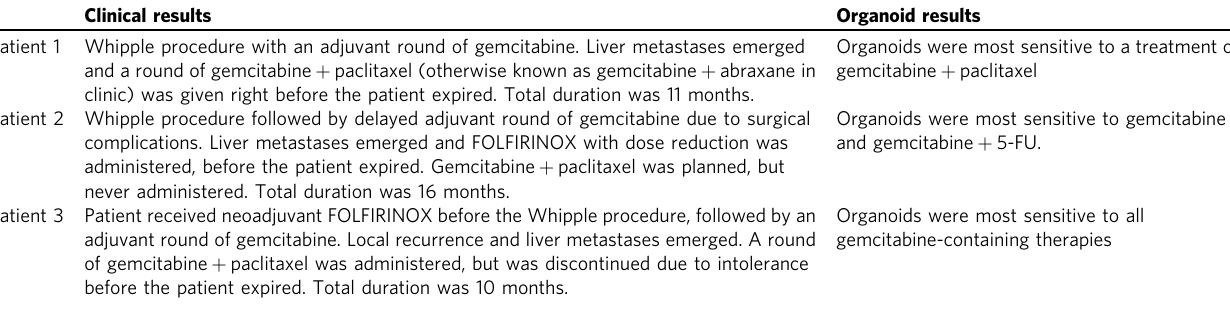
Table 2 Retrospective clinical data compared to corresponding patient ′ s organoid drug sensitivity results. Clinical results Organoid